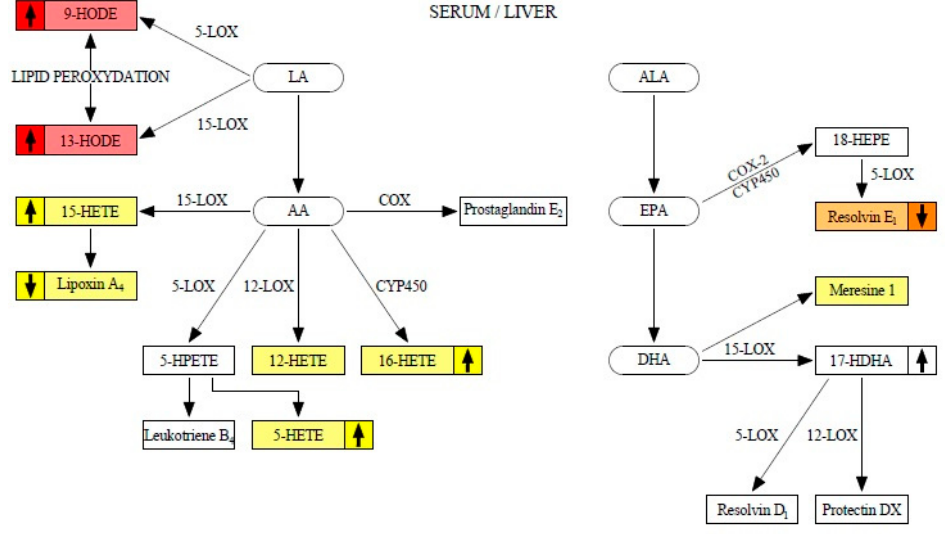
Figure 1. Eicosanoids metabolism.